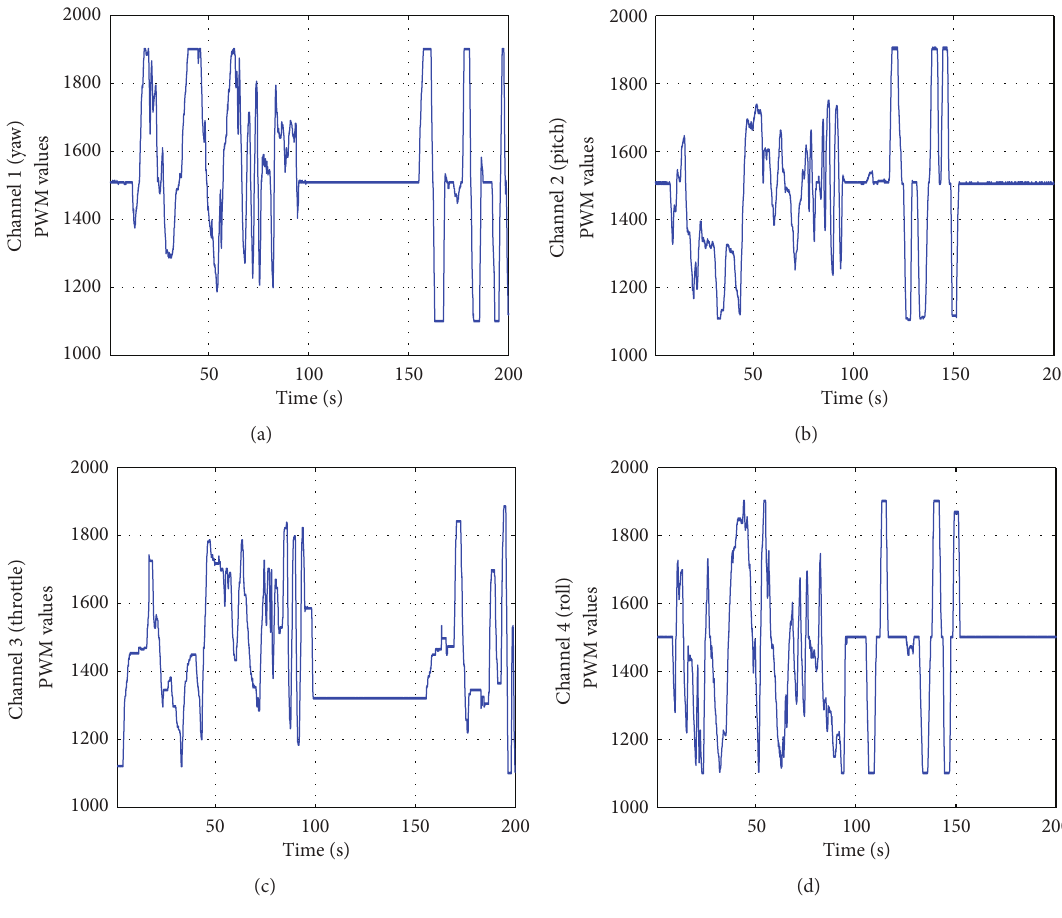
Figure 13: Flight control PWM signals in the ground